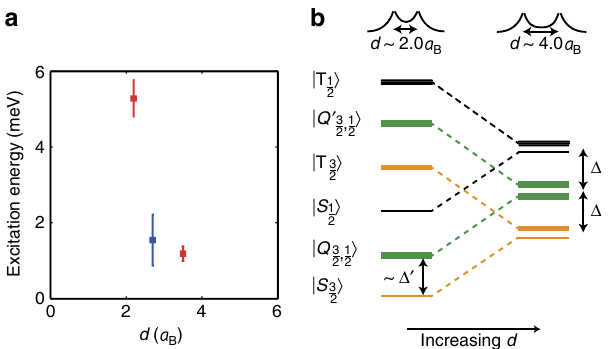
Figure 5 | Coupled-spin excitation spectrum. ( a ) Measured energy of first excited state relative to ground state. ( b ) Schematic level diagram of coupled acceptors, reflecting theory calculations, as a function of inter- acceptor distance d / a B . Singlets S m j i and triplets T m j i are present for J J interactions between two holes of m J ¼ ± ‘3/2’ spin (orange) and two holes of m J ¼ ± ‘1/2’ (black) spin. States | Q 3/2,1/2 i and j Q 0 are sets of four 3 = 2 ; 1 = 2 i closely spaced levels (green) with one ‘3/2’ spin hole and one ‘1/2’ spin hole. Error bars denote 95% confidence